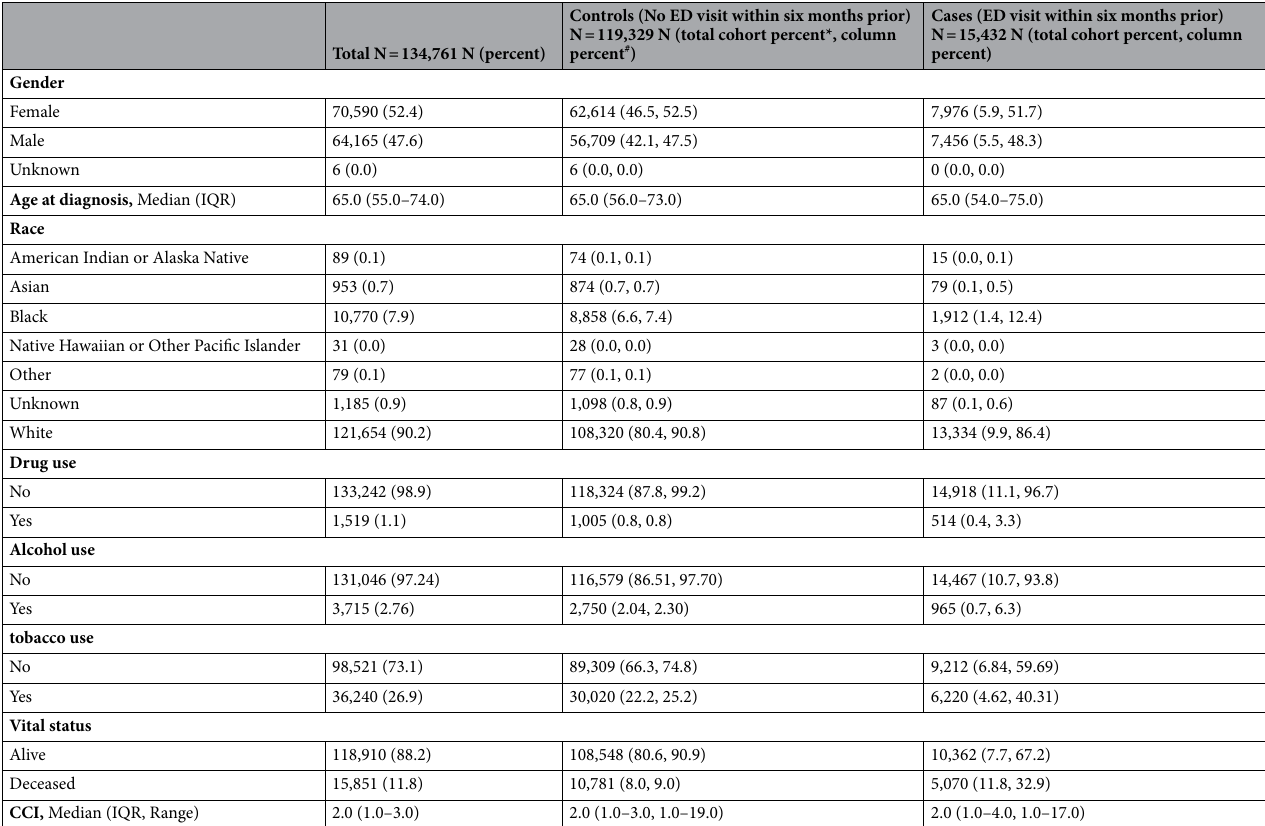
Table 1. Characteristics of the study population. Abbreviations: ED-emergency department, CCI-Charlson comorbidity index.